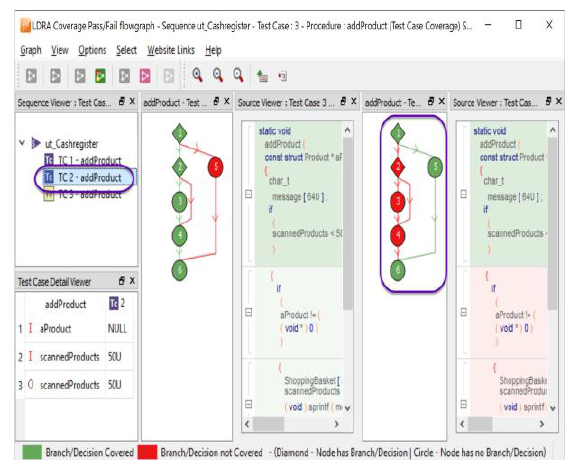
Fig. 9. Code Flow